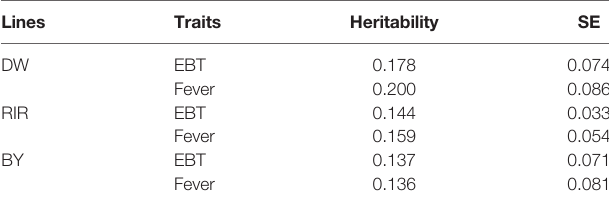
TABLE 2 | Heritability of early body temperature and fever. Lines